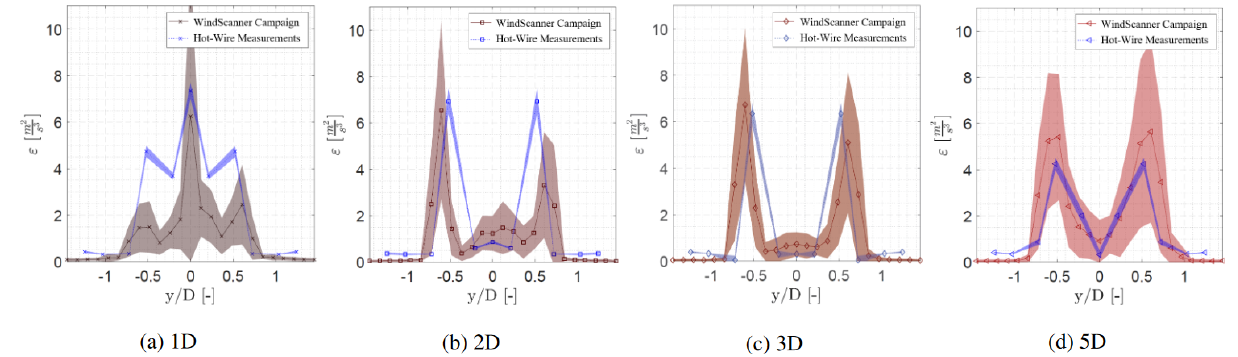
Figure 15. Comparison of the profiles of the averaged energy dissipation rate at 1, 2, 3, and 5 D between the WindScanner measurements and the hot-wire measurements at Neunaber (2019). Both measurements were conducted with no grid at U = 7 . 5ms − 1 . The shaded area shows the ± σ of the measurement data.